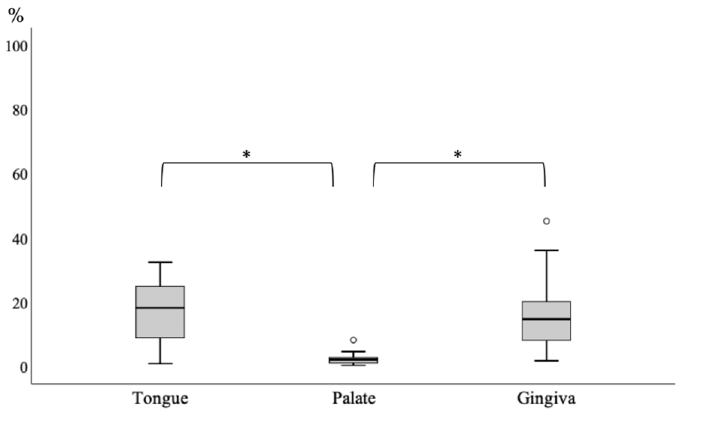
Figure 2. Comparison of positive proportion between groups of cytology site (n = 20). (Friedman test ( p < 0.01) and Wilcoxon signed-rank test.)